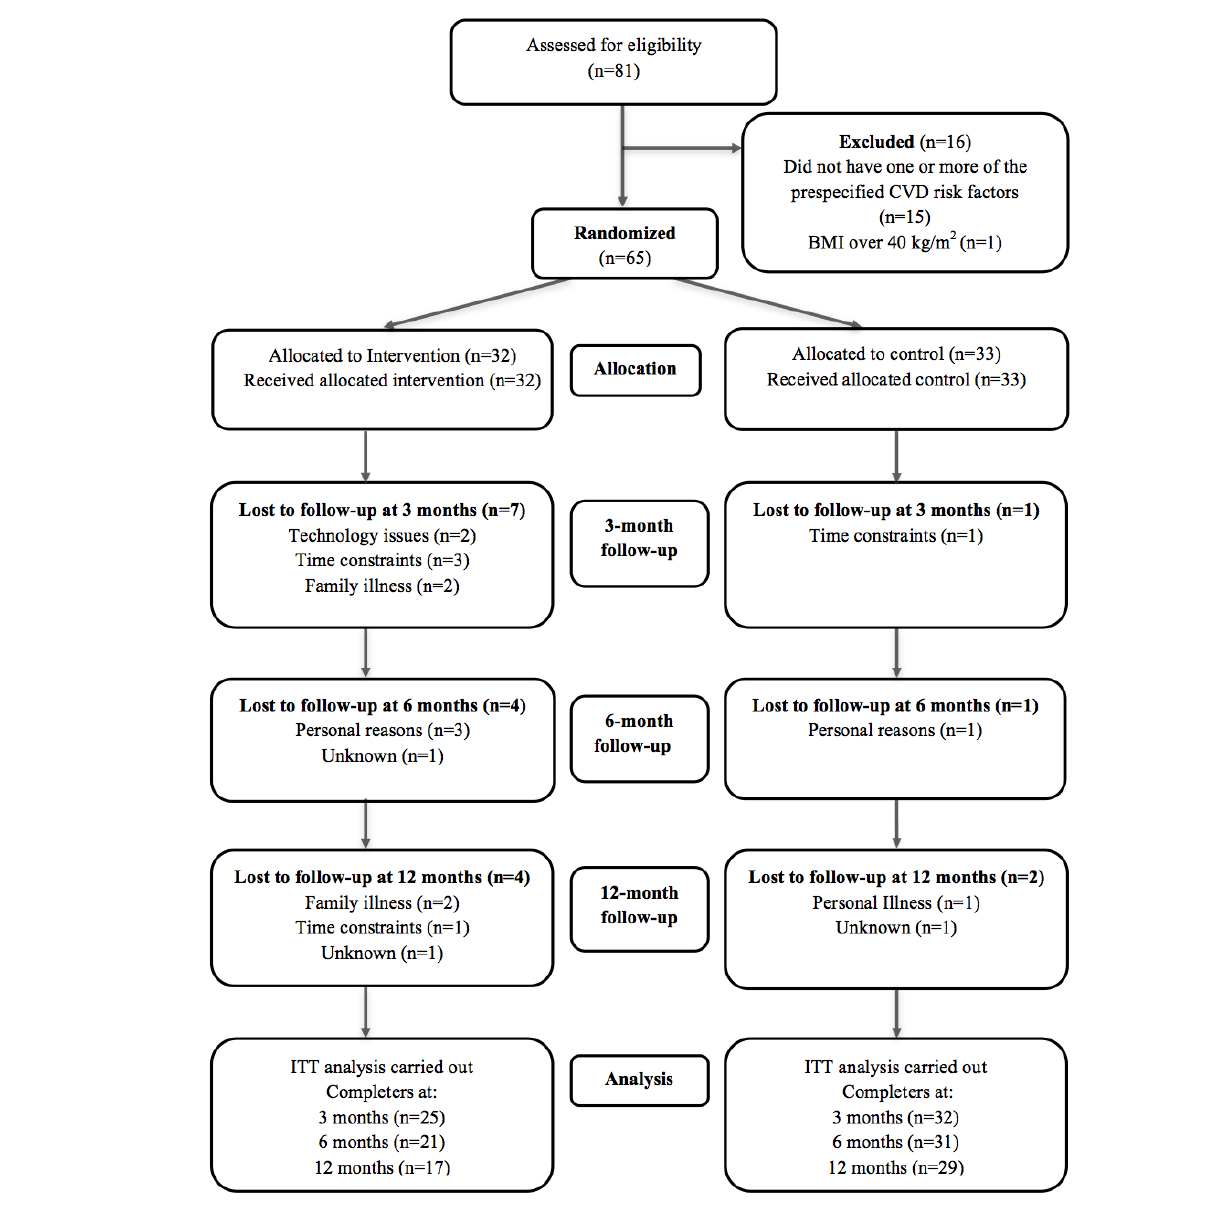
Figure 4. CONSORT diagram showing the flow of participants through the trial and analyzed for weight loss at 3 months, 6 months, and 12